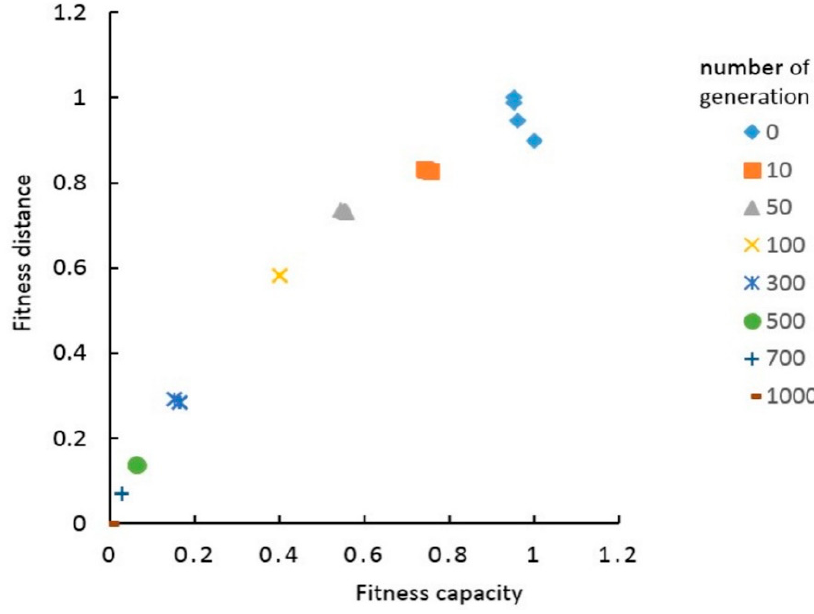
Figure 15. Pareto front set for different numbers of generations.